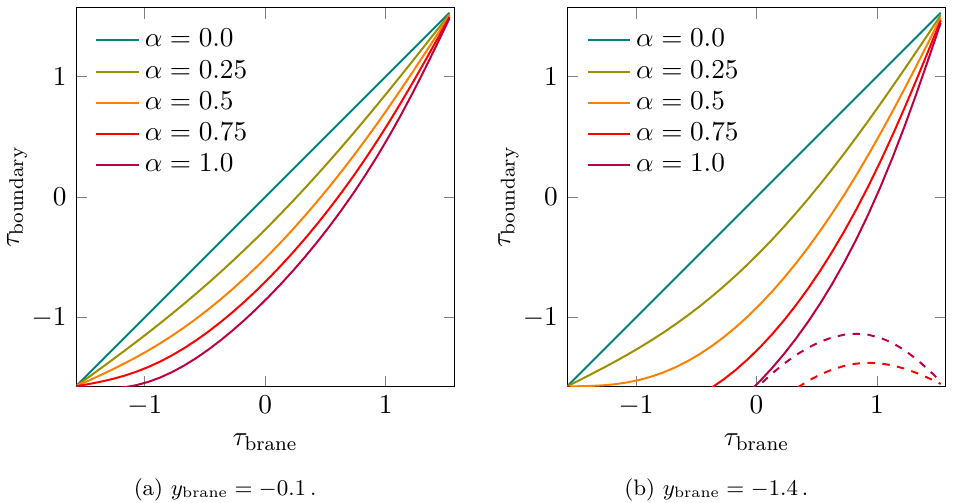
Figure 6 . The relation between the time τ brane at which a connected extremal surface connects to the brane and the time τ boundary at which it connects to the asymptotic boundary. (a) For y brane = 0 . 1 , we see that even for α = 1 . 0 the map between τ boundary and τ brane is one-to-one − and thus all extremal surfaces connect the brane and boundary in the same universe. (b) For y brane = 1 . 4 , a value of α 0 . 75 is sufficient for extremal surfaces to connect to other universes. − ≥ The τ coordinate for the extremal surfaces of the dashed lines is ˜ τ brane = τ brane